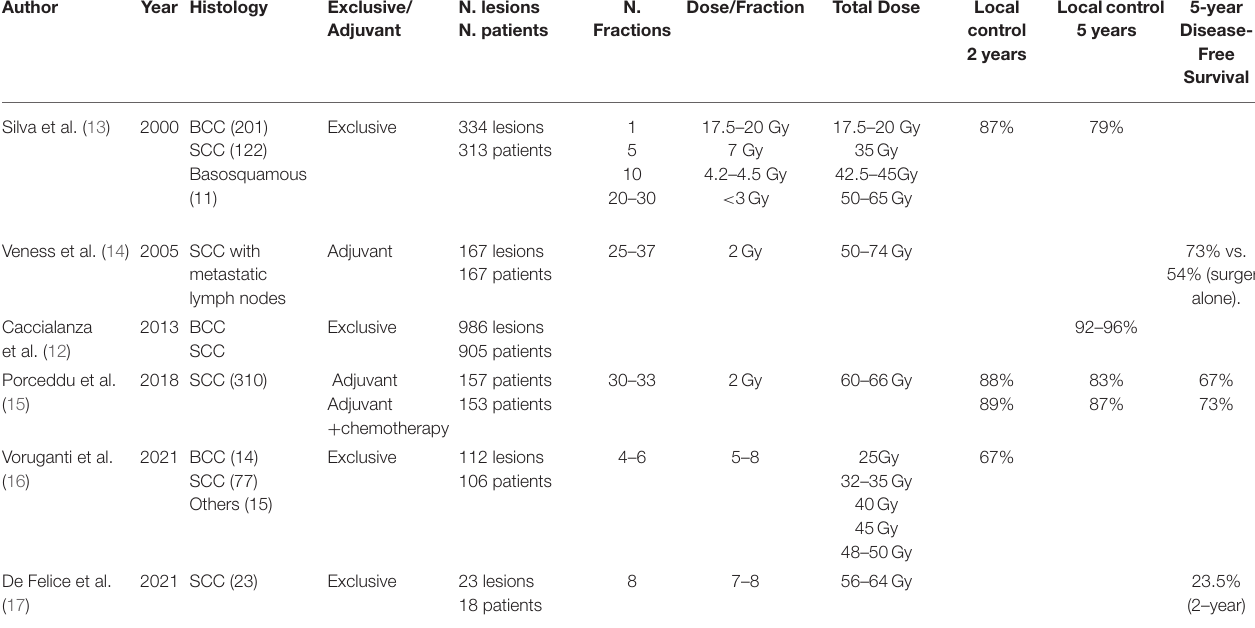
TABLE 1 | Classic external beam